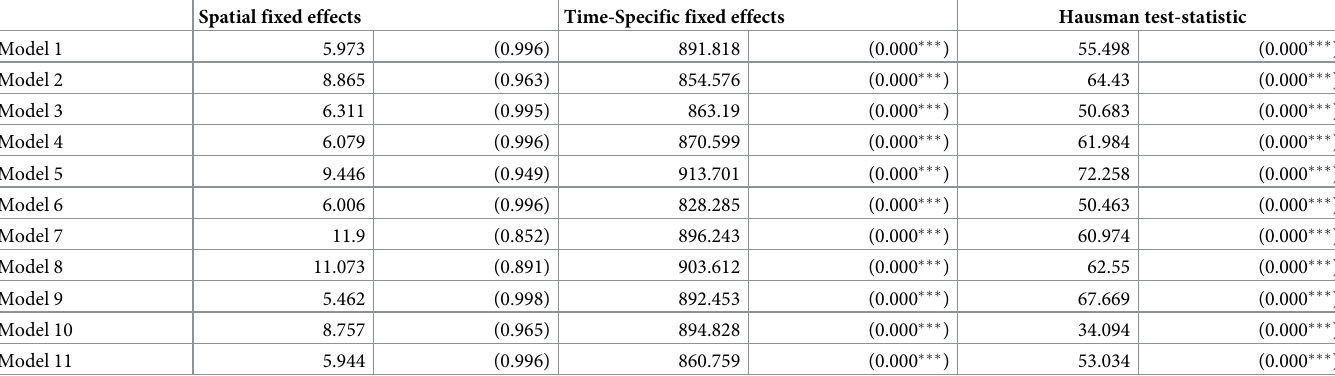
Table 3. The LR test for the existence of the spatial and time-specific fixed-effect in the models and Hausman test results. Spatial fixed